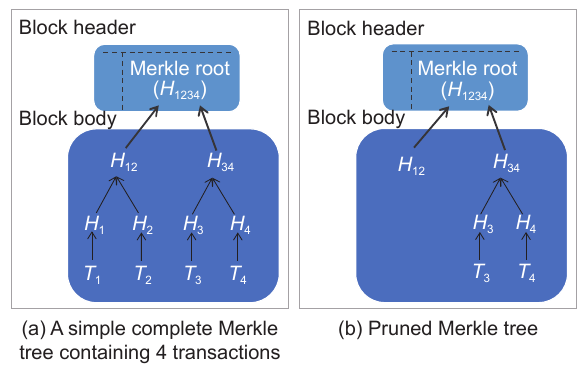
Fig. 4 Illustration of Merkle tree in a block.